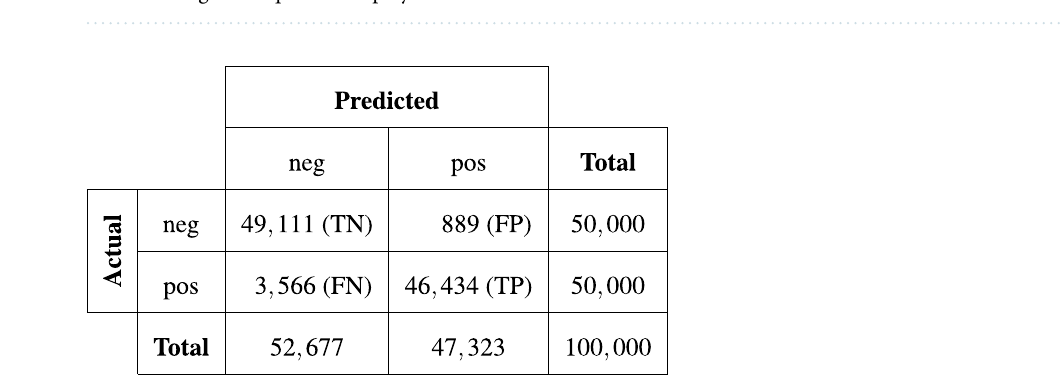
Figure 2. ROC curves for different training set sizes N s and a fixed LR of η = 10 data handling technique was employed.